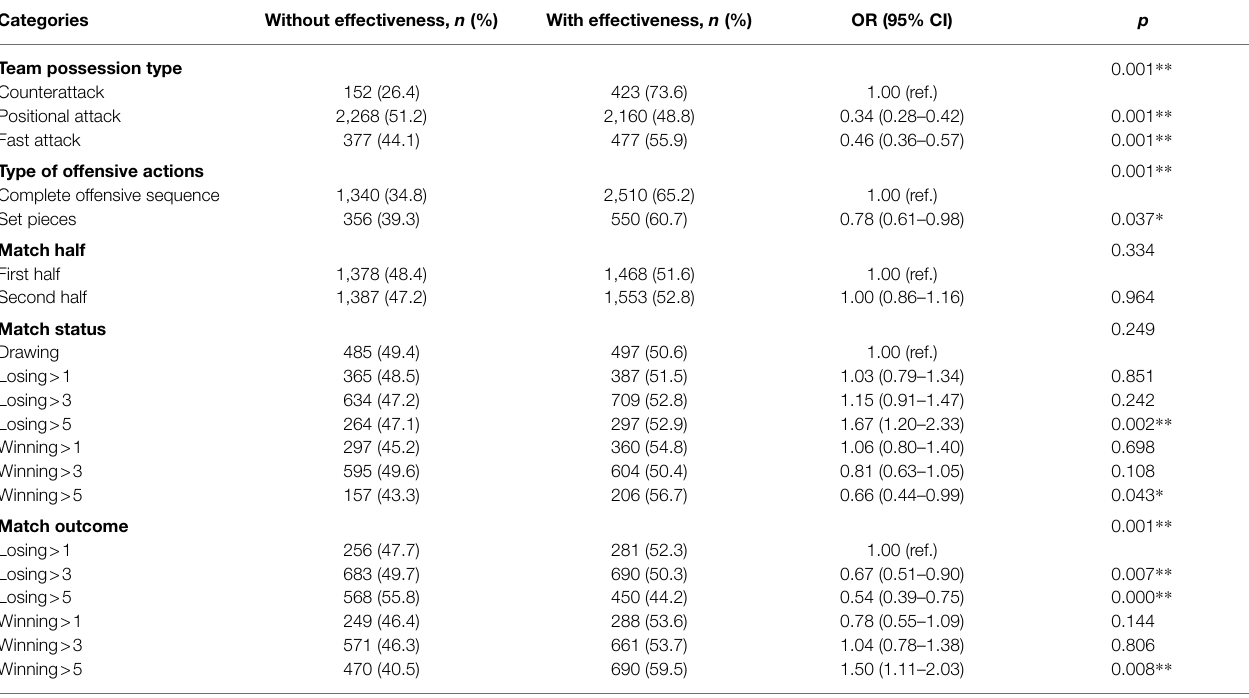
TABLE 4 | Differences in possession outcome according to team position type and situational variables.